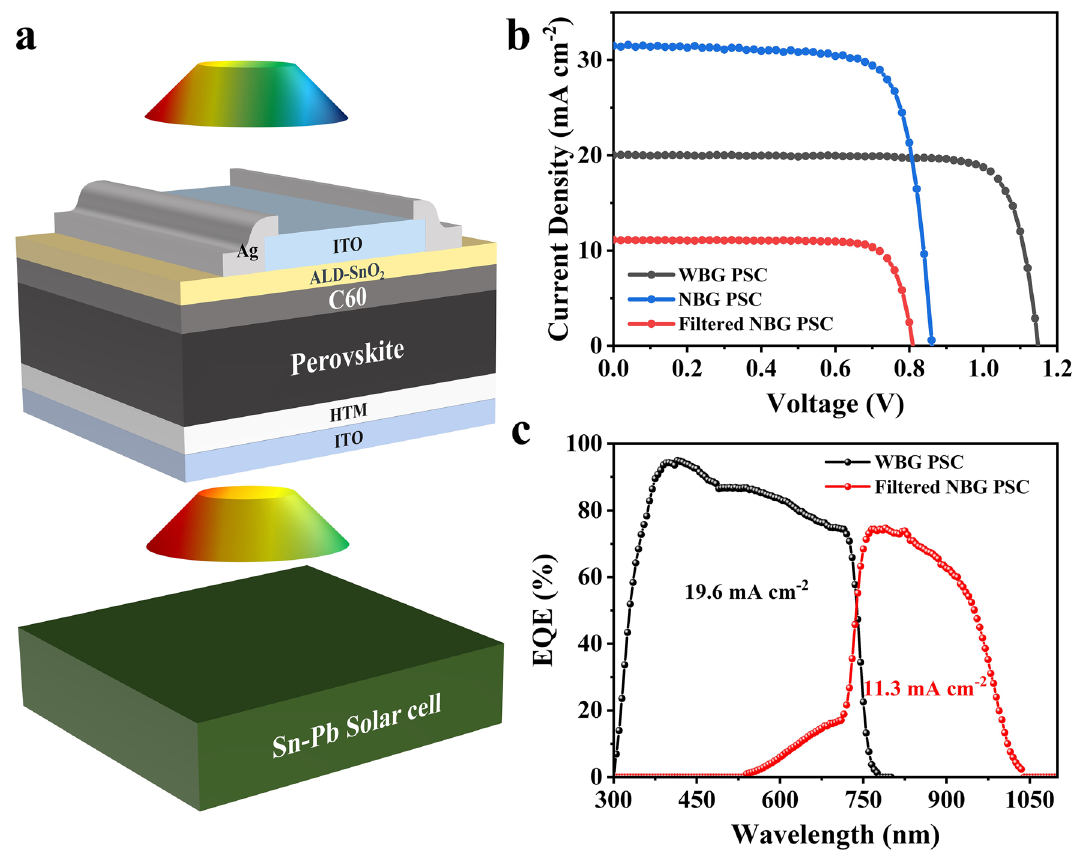
Fig. 6 a Schematic device configuration of a 4-T perovskite/perovskite tandem cell. b J - V curves and c EQE spectra of a 4-T perovskite/perovs- kite tandem cell